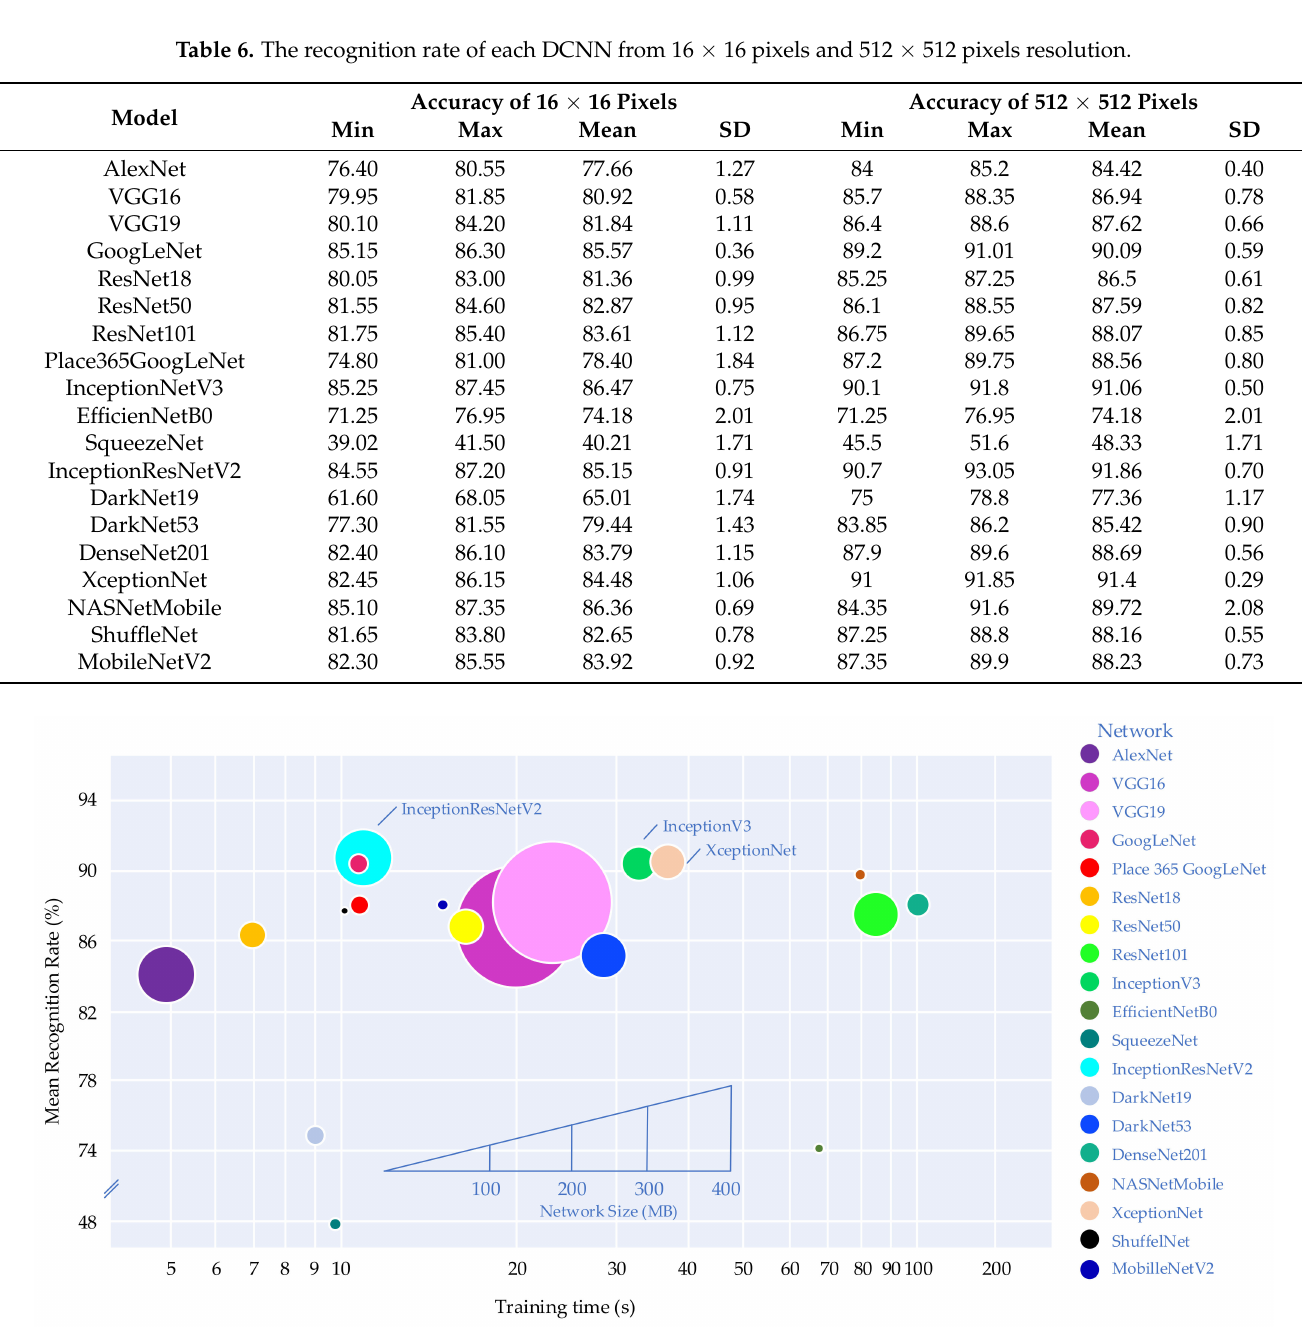
Figure 20. The recognition rate of each DCNN from 512 × 512 pixels resolution. Figure 20 compares recognition rate, training time, and network size obtained from nineteen DCNNs. All networks were trained using MATLAB R2021a platform with Deep Learning (DL) Toolbox. In this test, a GPU (Nvidia GTX1707, US) was employed. It can be seen that AlexNet required the shortest training time (5 s/image) due to its simple archi- tecture. On the other hand, DensNet201 required the longest training time of 108 s/image with complicated architecture. When comparing the performance of InceptionResNetV2, XceptionNet, and InceptionNetV3, InceptionResNetV2 provided the shortest training time (11.23 s/image) and the highest recognition rate. This DCNN model was then used for further testing with multiple handling of the object. Note that the network size of InceptionResNetV2 was slightly larger than that of InceptionV3 and